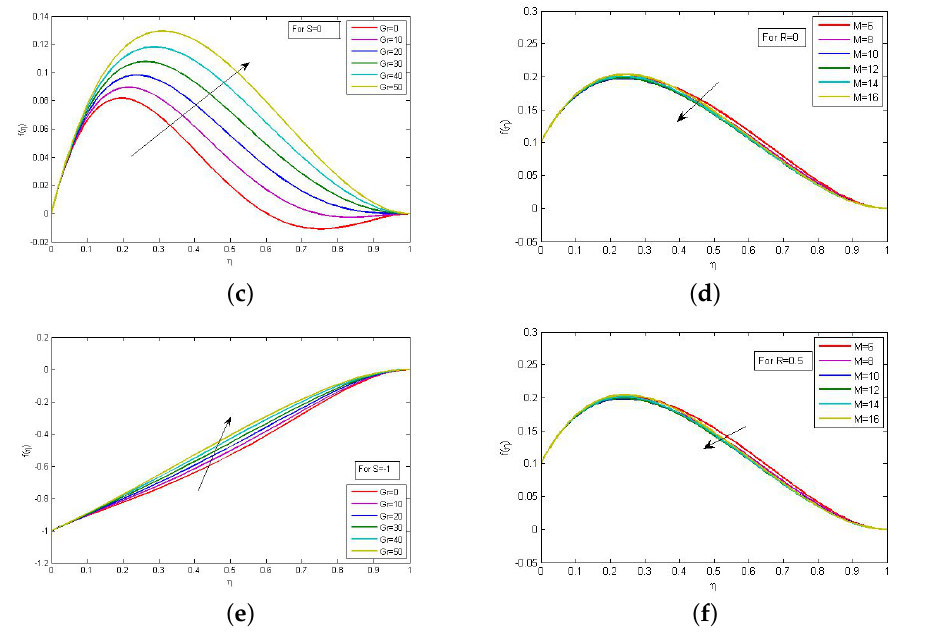
Figure 4. Effect of Gr on f (cid:48) ( η ) for cases ( a ) S = 1.0 ( c ) S = 0.0 ( e ) S = − 1, and of M over f (cid:48) ( η ) for cases ( b ) R = 1.0 ( d ) R = 0.0 ( f ) R = 0.5.